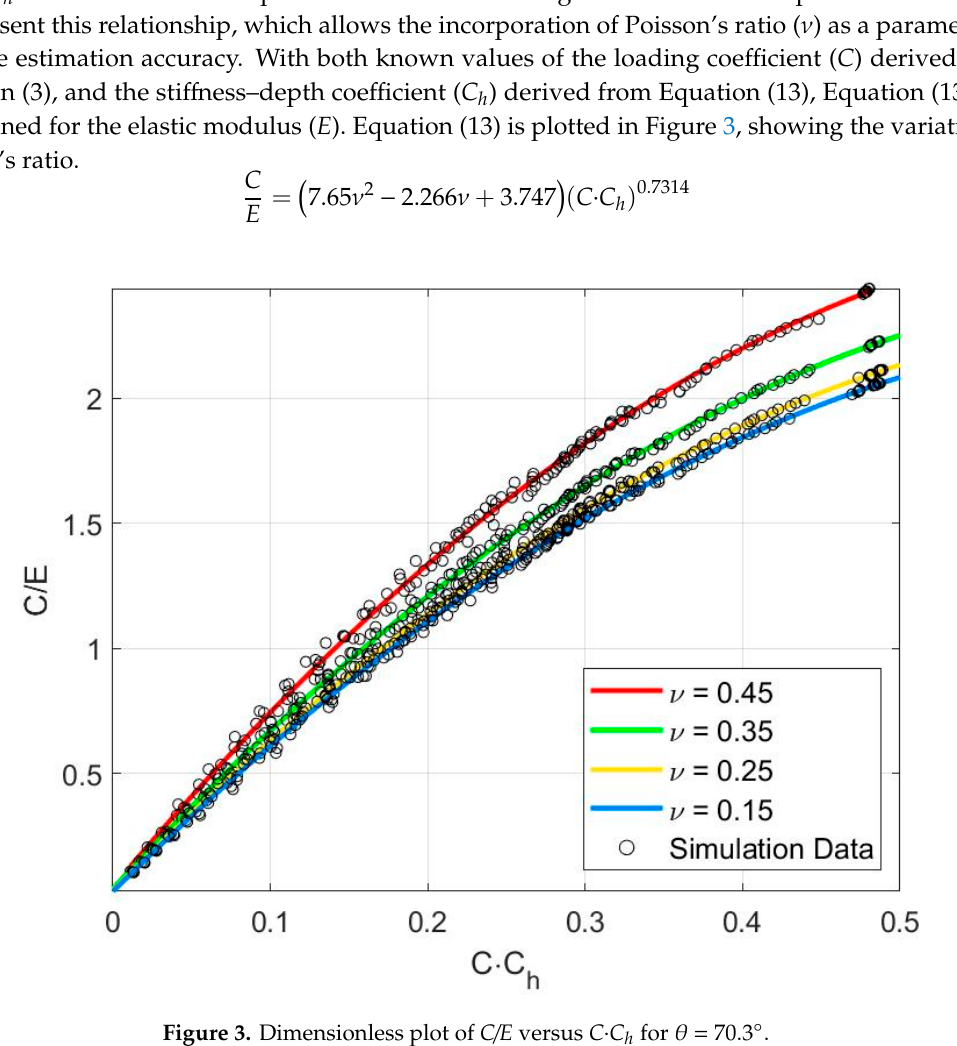
Figure 3. Dimensionless plot of C/E versus C ∙ C h for θ = 70.3°.